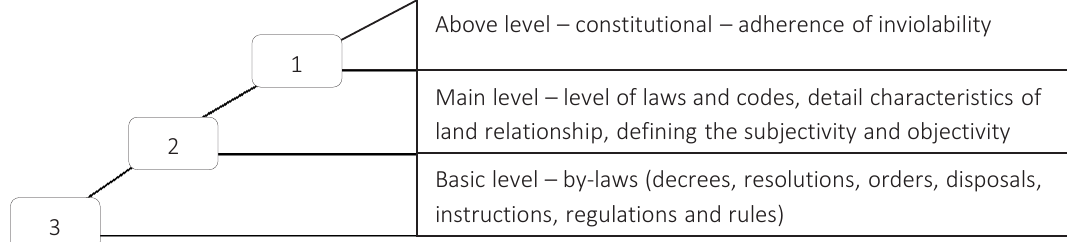
Above level – constitutional – adherence of inviolability and land ownership Main level – level of laws and codes, detail characteristics of land relationship, defining the subjectivity and objectivity Basic level – by-laws (decrees, resolutions, orders,